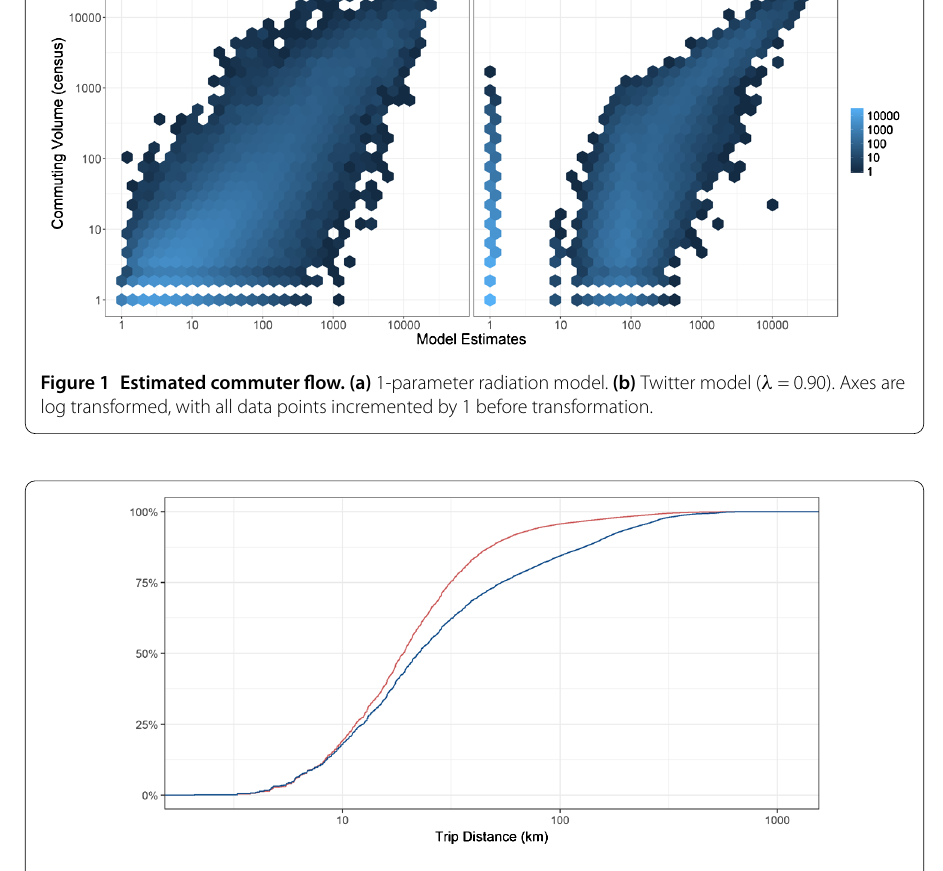
Figure 2 Empirical cumulative distribution of commuting trip distances. Red: census data. Blue: Twitter